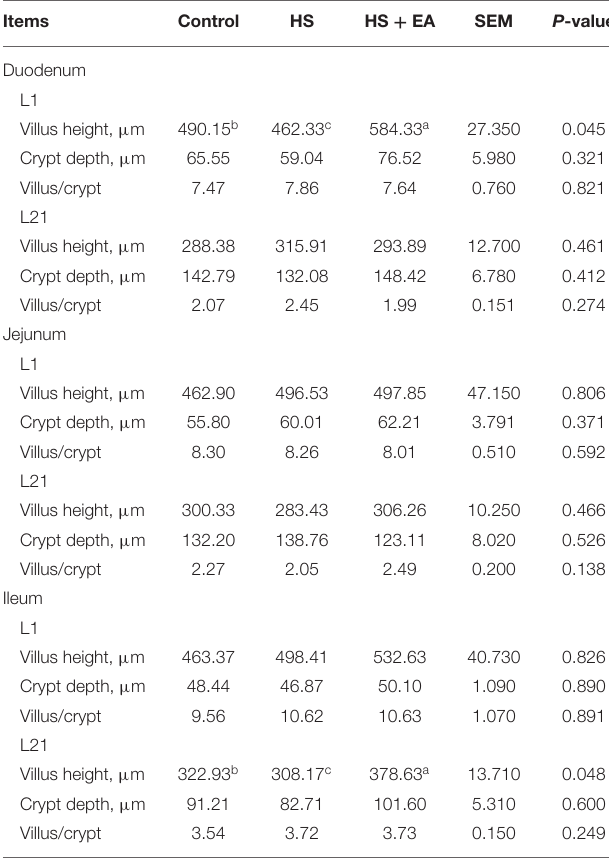
TABLE 10 | Effects of maternal dietary supplementation with EA on small intestinal morphology of nursing